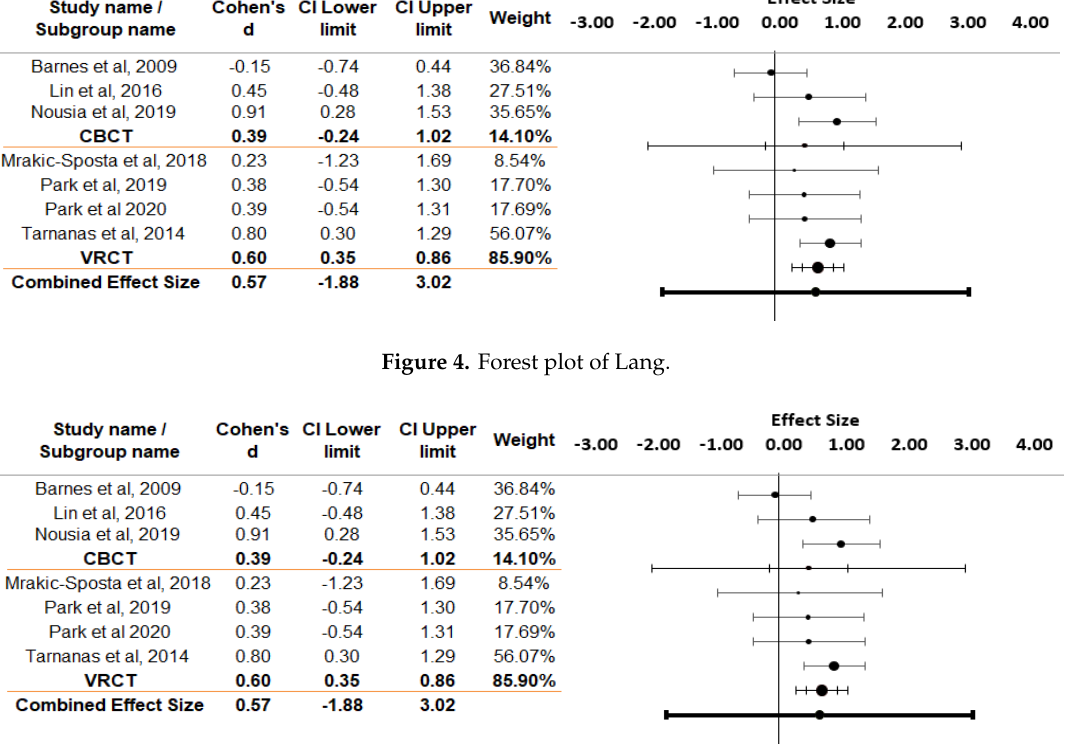
Figure 5. Forest plot of visuospatial skills (VS).